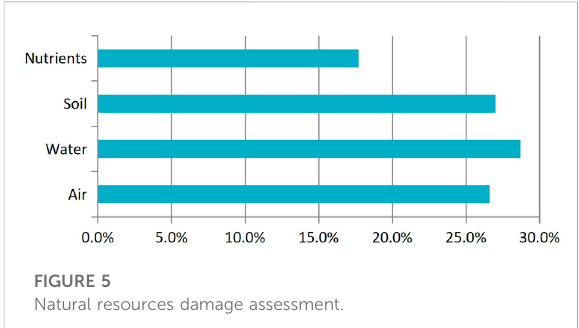
FIGURE 5 Natural resources damage